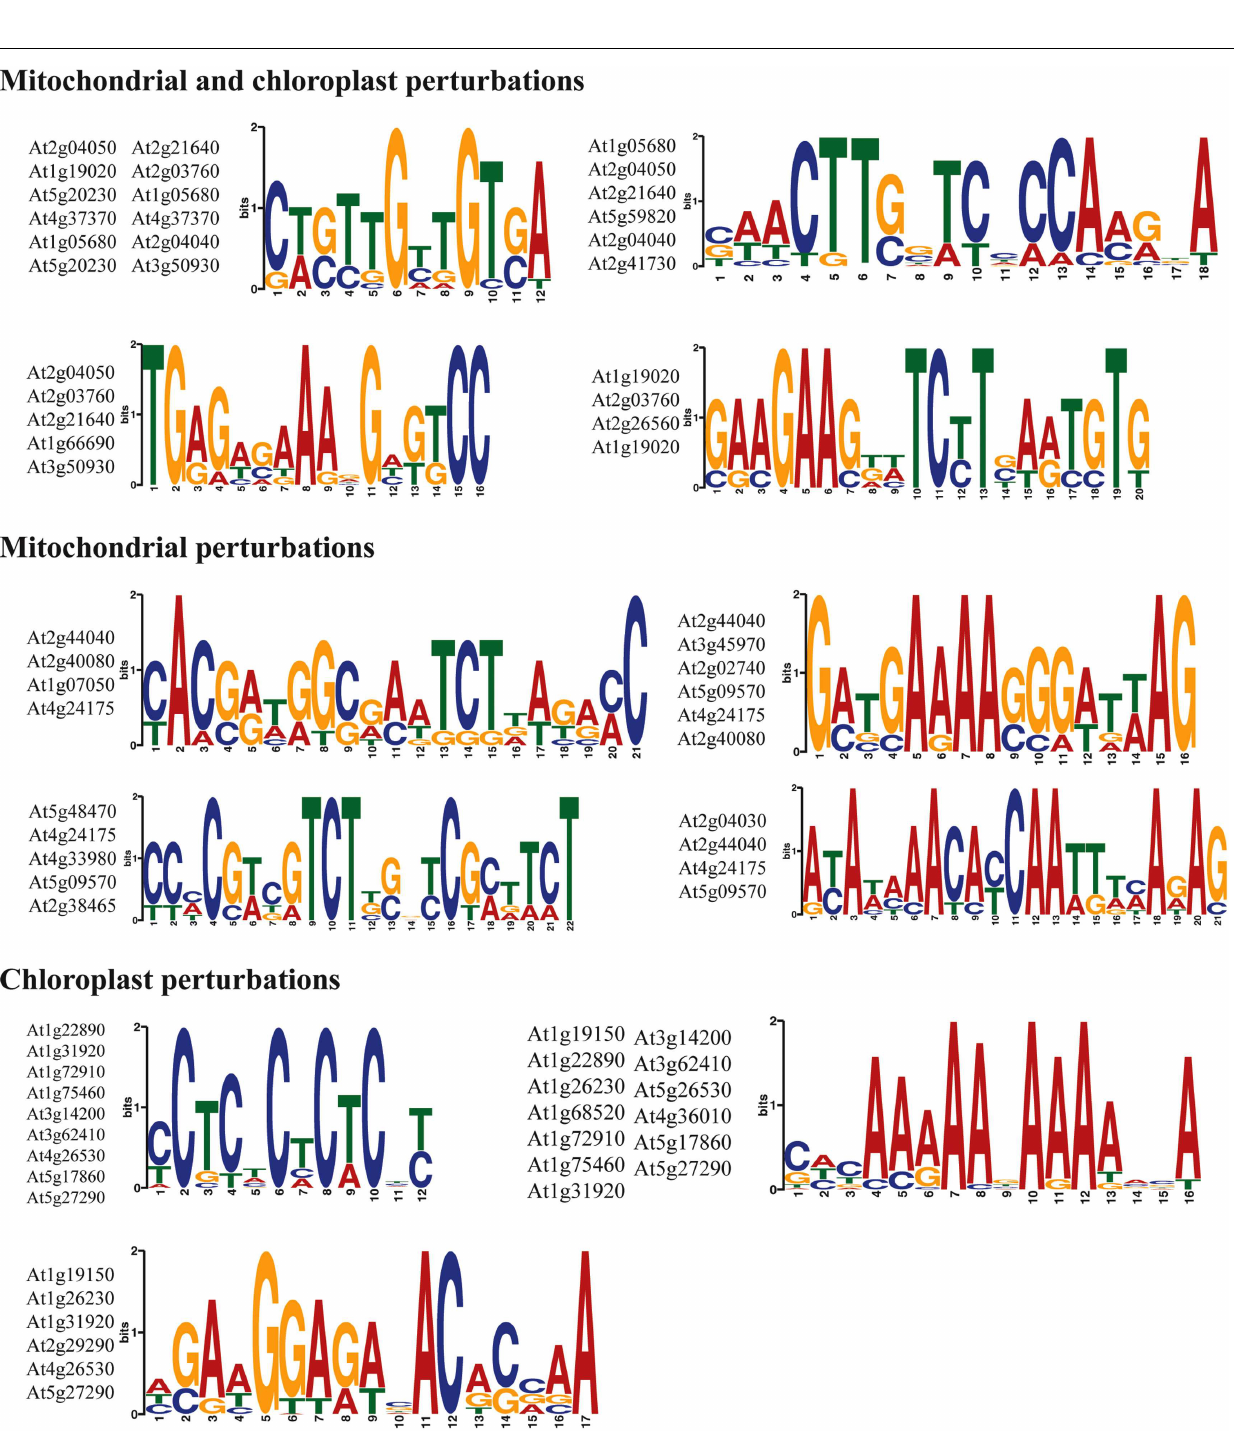
FIGURE 5 | Discovery of sequence motifs in the promoters of marker genes for retrograde regulation. The 1kb upstream promoter regions were searched for common motifs using the MEME suite. Sequence consensus logos and the genes in which the promoter motifs occurred are shown.